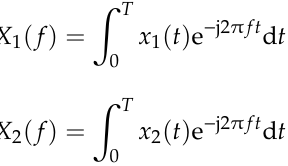
Figure 2. The PD pulses; ( a ) before pulse separation; ( b ) after pulse separation.